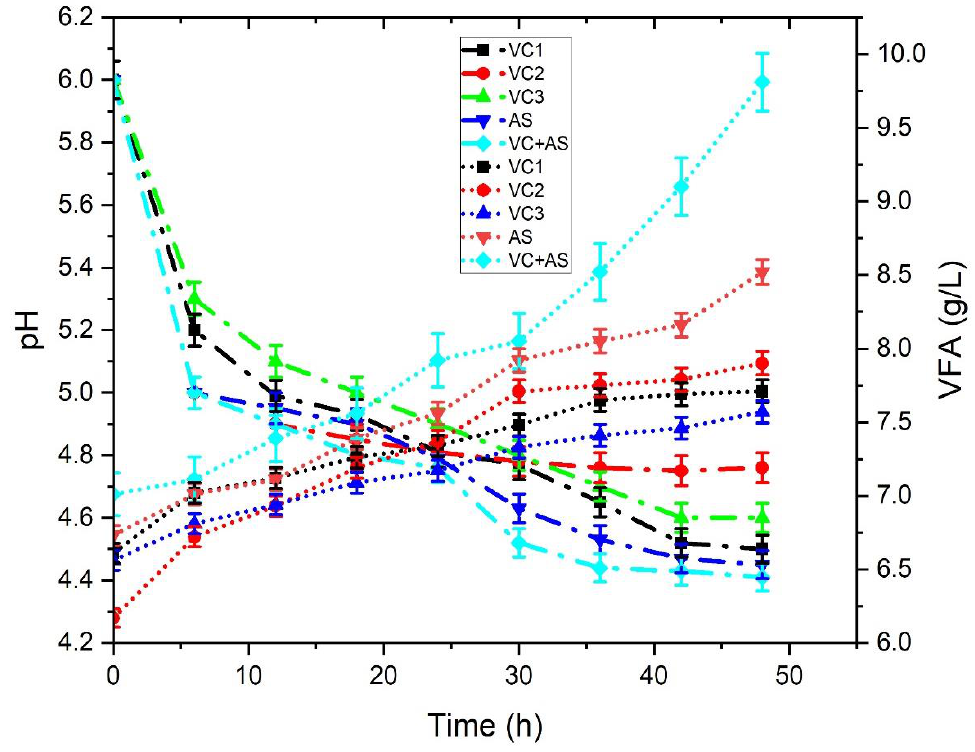
Figure 6. pH and VFA changes concerning different experimental reactors.